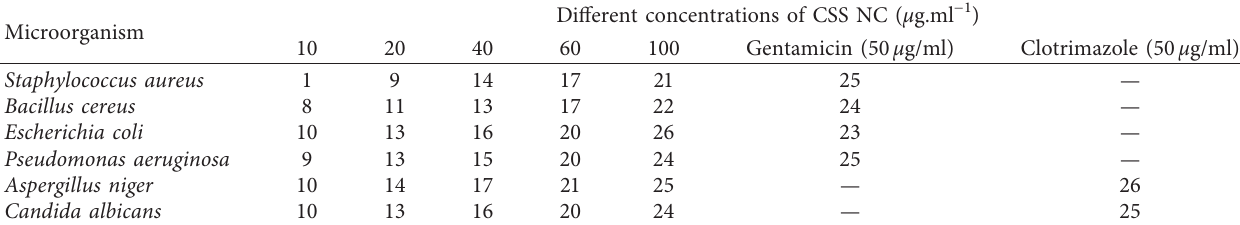
Table 3: Nonmicrobial growth diameter at various CSS NS concentrations by diffusion from wells (in millimeters). Microorganism